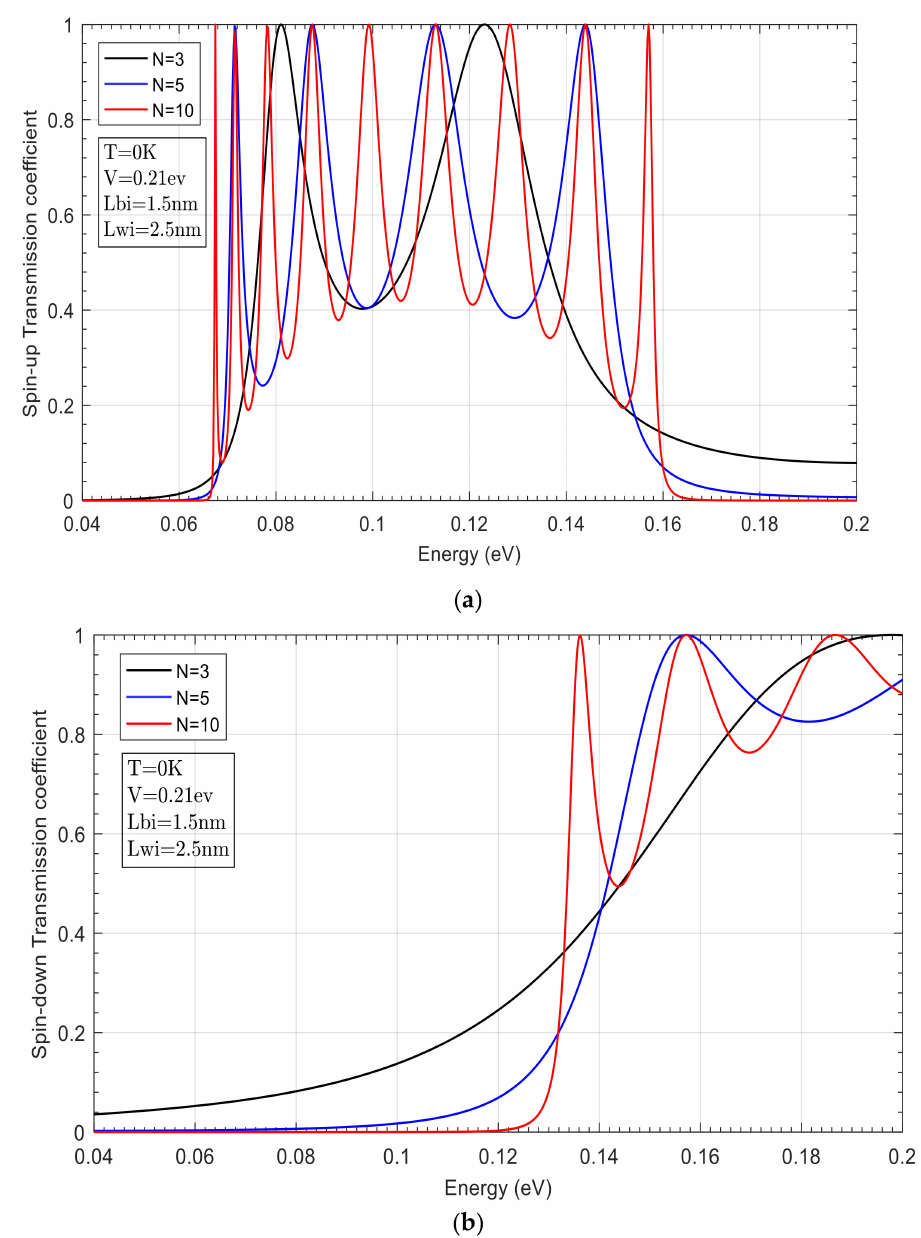
Figure 3. ( a ): The transmission coefficient of spin-up holes as a function of incident energy for three barrier numbers (N = 3, 5, and 10). ( b ) T = 0 K. Transmission coefficient of spin-down holes as a function of incident energy for three barriers numbers (N = 3, 5 and 10). T = 0